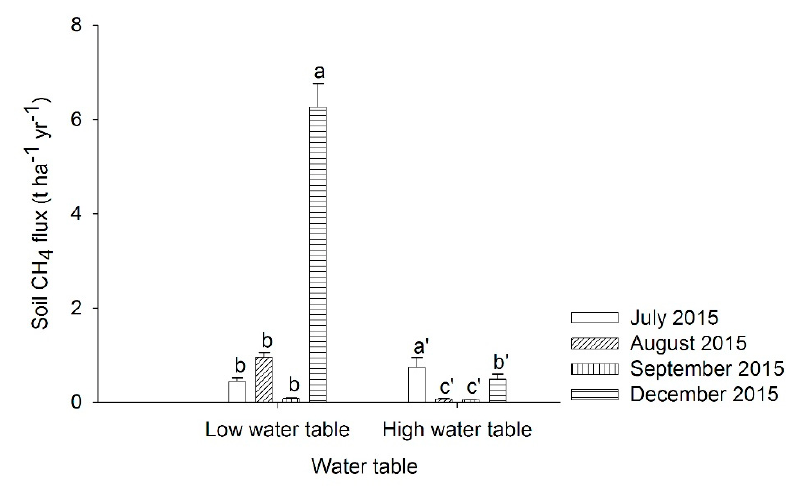
Figure 9. Averaged soil CH 4 emissions over 24 h from a peat soil cultivated with pineapples in lysimeters under low and high water tables throughout the dry (July and August 2015) and wet (September and December 2015) seasons. Error bars represent standard error and soil mean fluxes with different letters and noted by prime are significantly different using DNMRT at p ≤ 0.05.